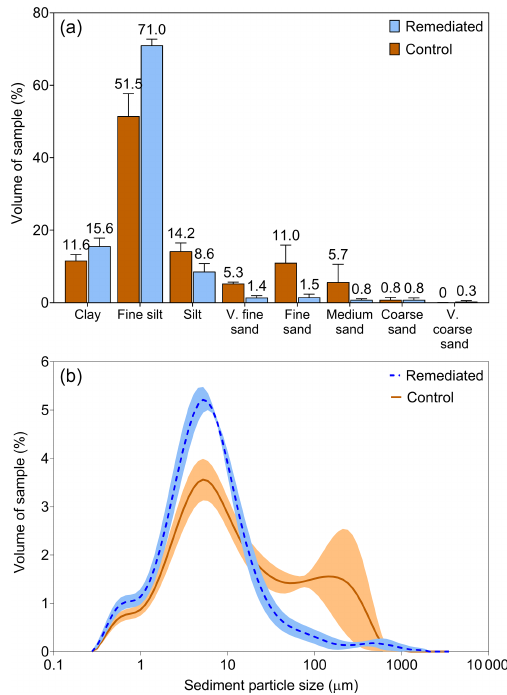
Figure 8. Average suspended sediment PSD by sediment size class (a) and plotted by frequency (b) for PASS samples collected from the control (brown) and remediated (blue) gullies during the 2018–2019 and 2018–2019 wet seasons. Error bars (a) and shad- ing (b) indicate the error as a standard deviation. Clay – < 2µm;